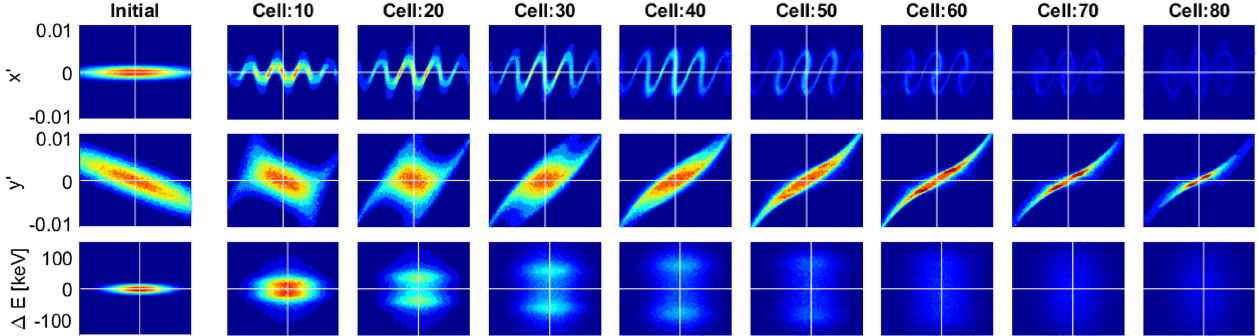
FIG. 19. Horizontal, vertical, and longitudinal phase space projection for every tenth cell. The axes are − 1 . 5 μ m < x < 1 . 5 μ m, − 0